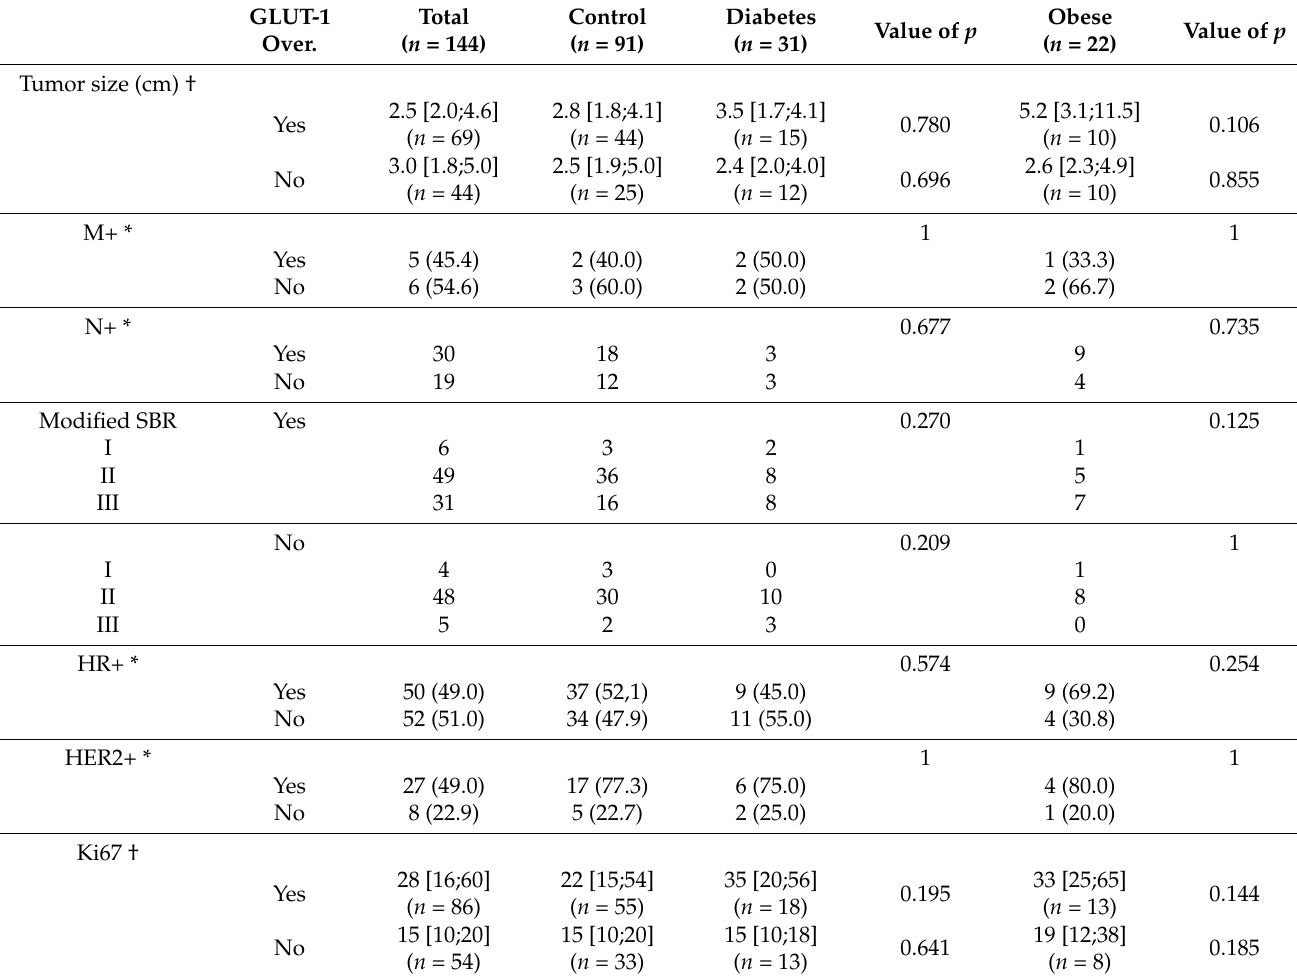
Table 8. Comparison of clinicopathological data and GLUT-1 expression between the diabetic and obese patients and the control group.